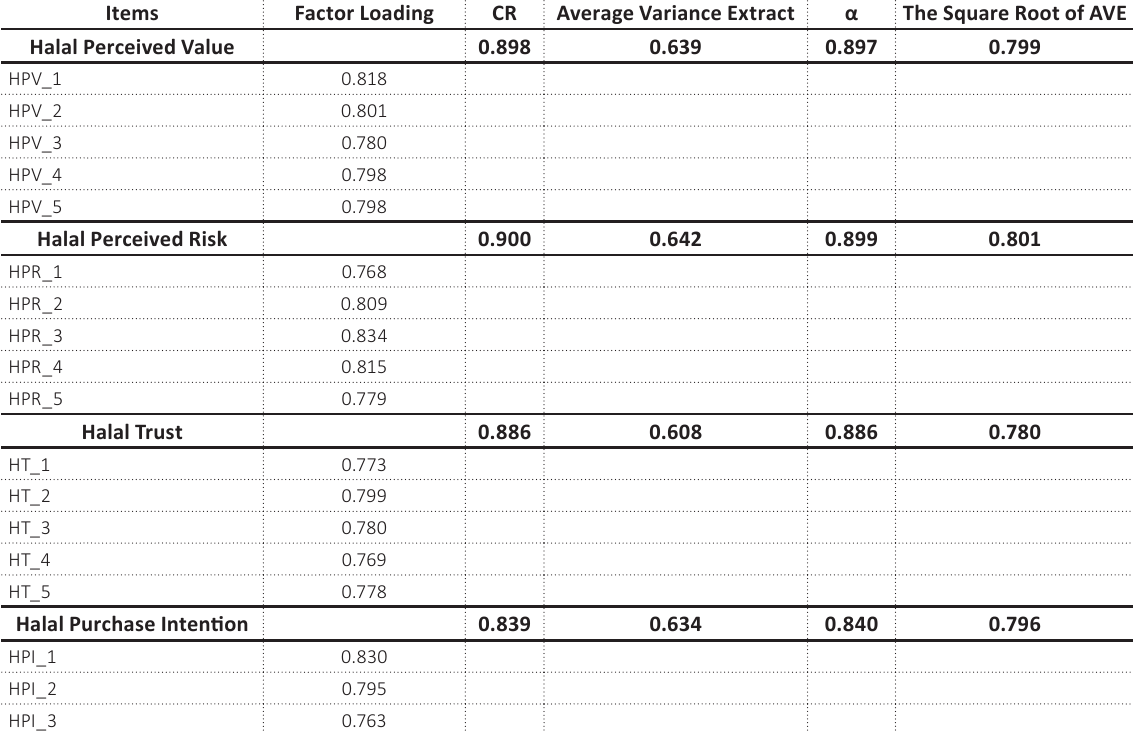
Table 2. Results of the measurement model